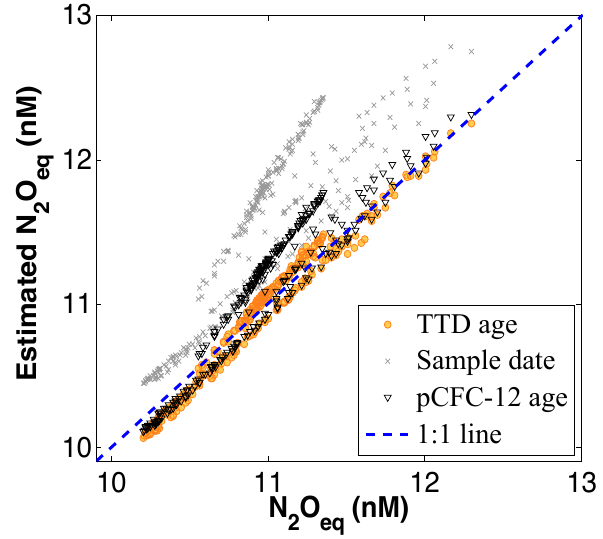
Fig. 1. The relationship between explicit model N 2 O eq values and N 2 O eq estimated from (1) the sampling date atmospheric N 2 O val- ues (in this case historical atmospheric N 2 O variations are not ac- counted for) (gray crosses, R 2 = 0 . 42), (2) CFC-12 ages (black tri- angles, R 2 = 0 . 85), and (3) mean ages derived from the transit time distribution (TTD) method conservatively assuming “high” mixing (a 1 / 0 ratio of 1) at each site (orange circles, R 2 = 0 . 96). The R 2 values indicate how well each dataset describes the 1 : 1 line shown above (blue dashed line) using the sum of squares method. Data were obtained from the region between 10 ◦ N–23.5 ◦ S, 200–290 ◦ E, and within the 26.25–26.75 σ θ density layer.